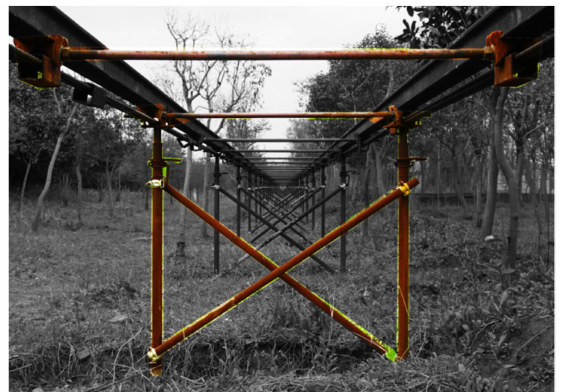
Figure 5. AERORail structure and support picture.